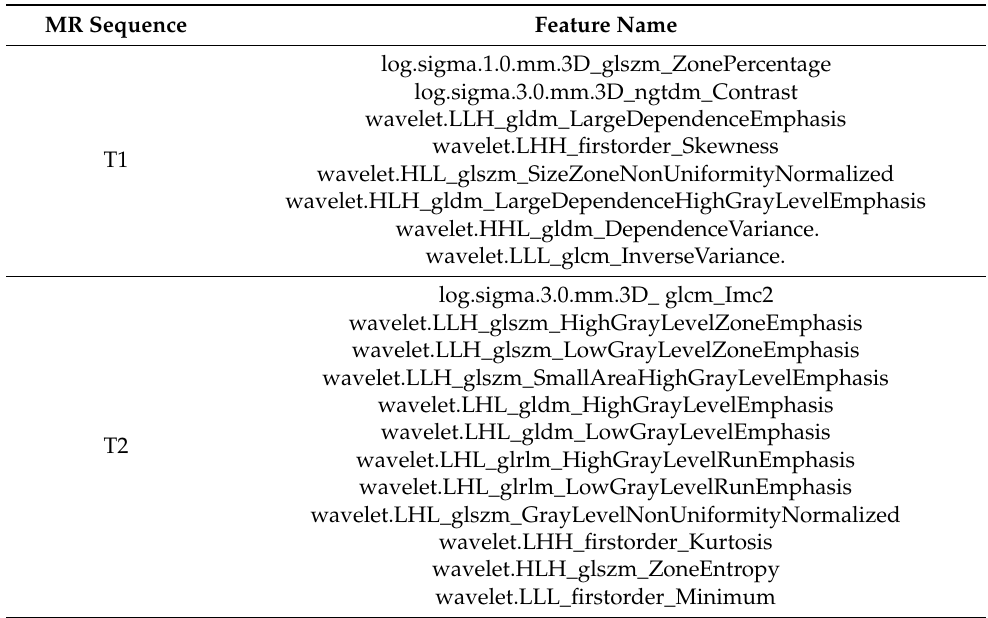
Table 2. Selected radiomic features by univariate logistic regression analysis and LASSO regression in training